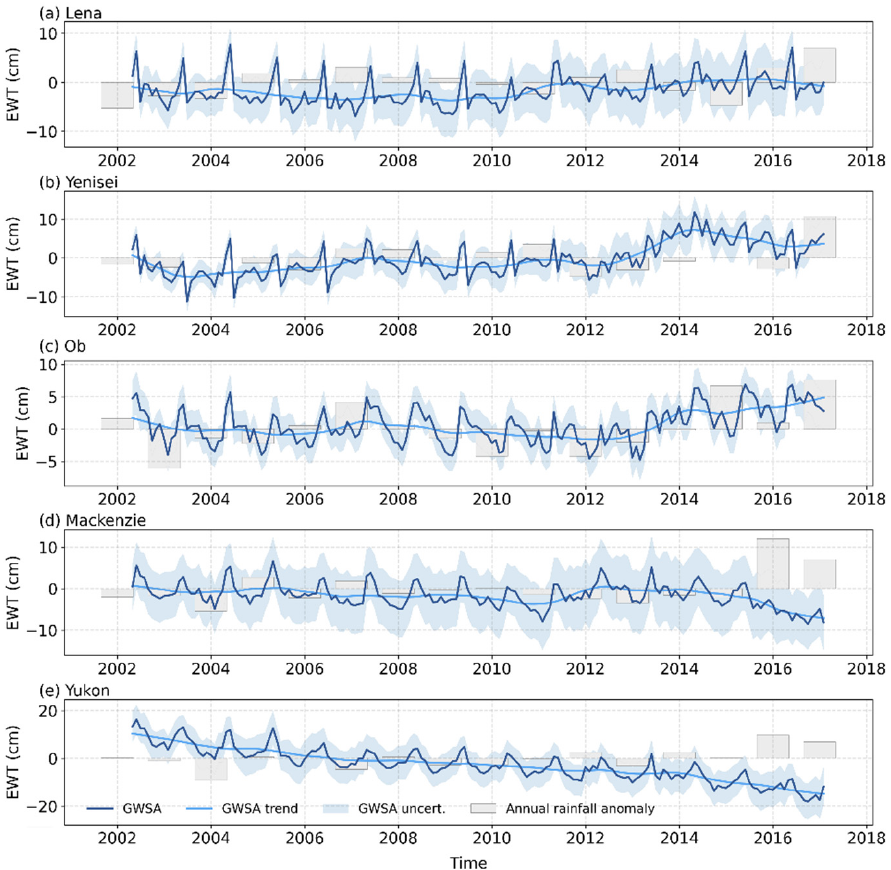
Figure 5. Monthly GWSA time series (deep blue line), trends in GWSA (light blue line), uncertainty in GWSA (light blue band), and annual rainfall anomaly (gray bar).